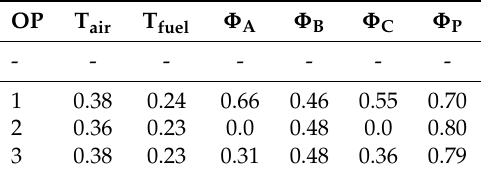
Table 1. Operating conditions for the investigated cases. Temperatures are normalized by a reference temperature T ref , which corresponds to the adiabatic temperature of the mass averaged equivalence ratio of each operating point